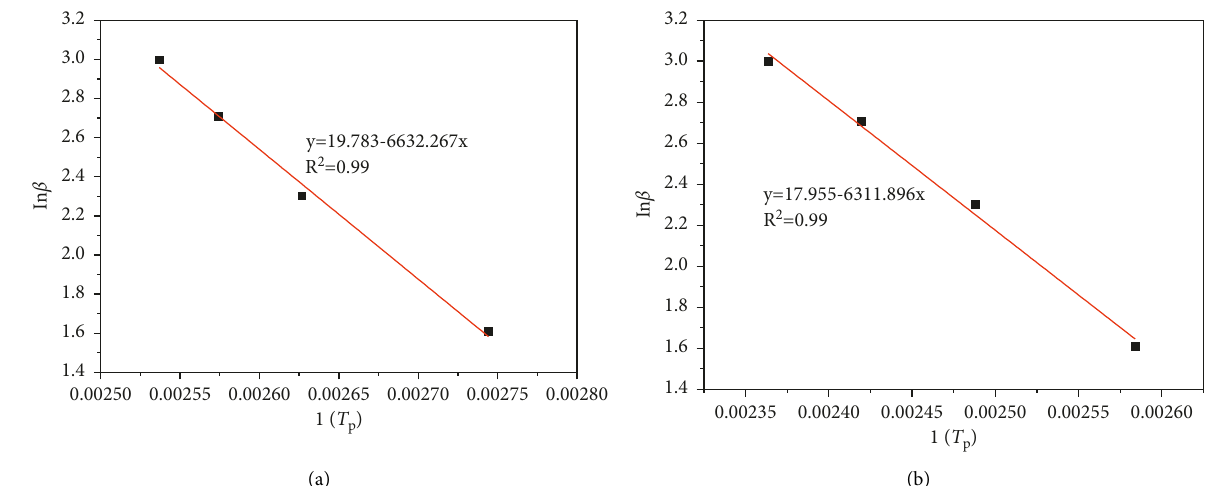
Figure 6: Fitting the curing curves of (a) CME and (b) HME based on the Crane equation.